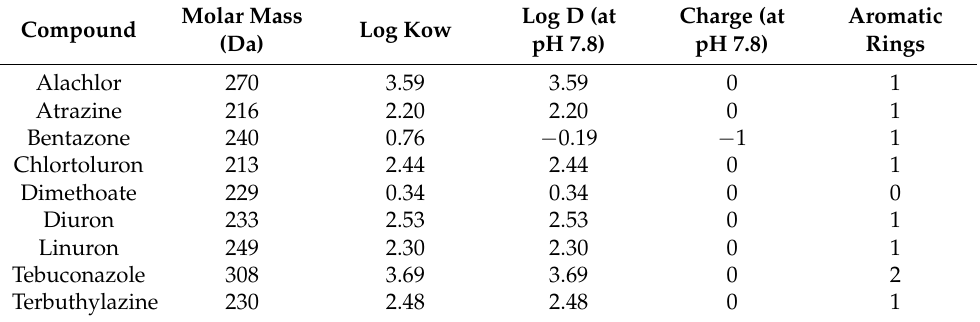
Table 1. Pesticides used to spike intake waters feeding PAC/coagulation/ceramic MF